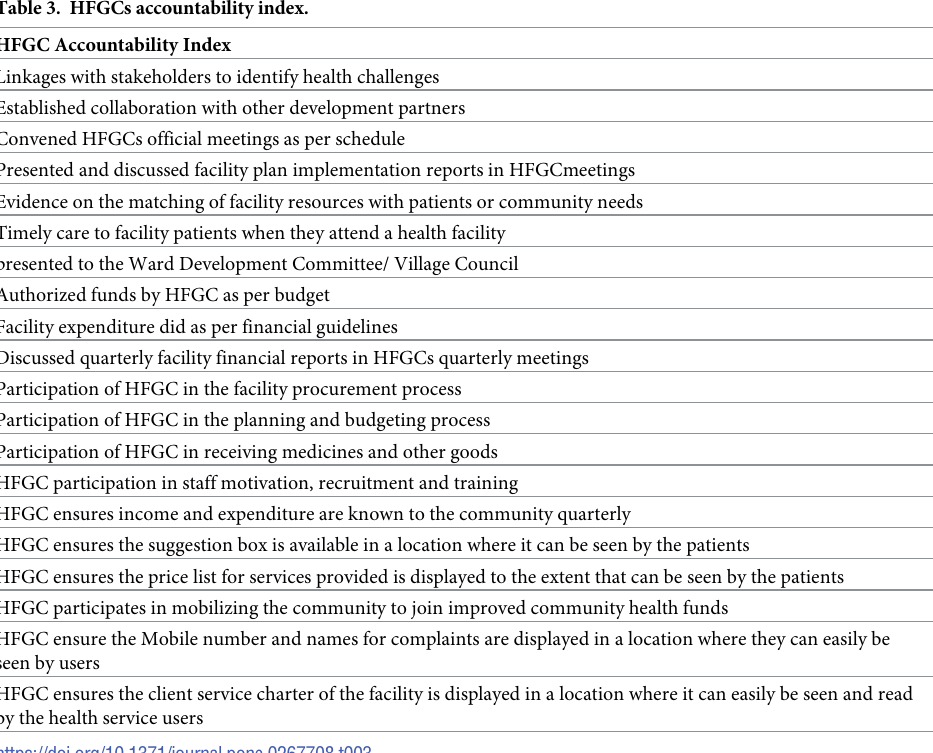
Table 3. HFGCs accountability